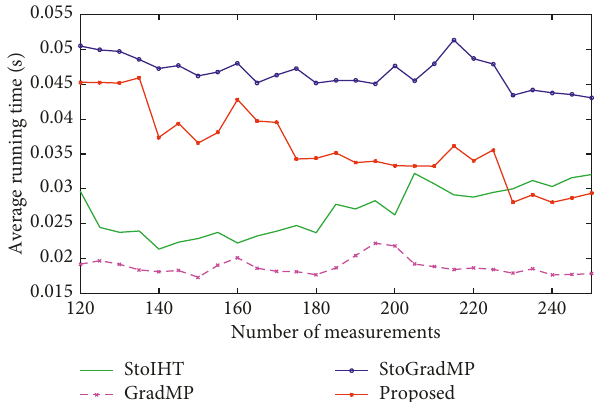
Figure 7: The average running time of different algorithms with different measurements ( n � 256, s � 20, t � 0.6, Gaussian